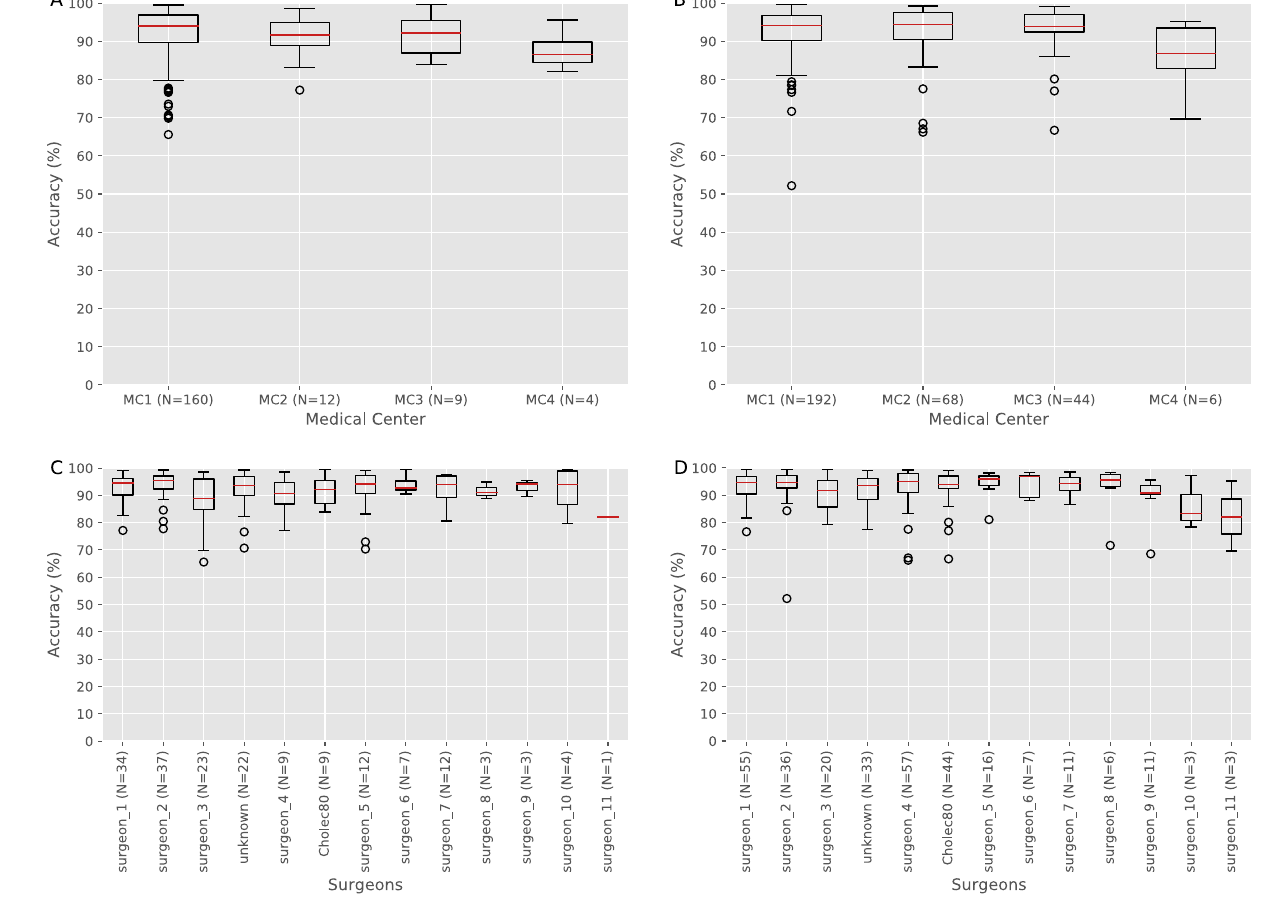
Figure 4. Medical centers and surgeons generalization evaluation. Accuracy boxplot for validation and test sets for different medical centers and surgeons. (N =) state the number of validation or test videos for each subset. Table S2. Only MC1-MC4 are shown since MC5-6 have only one sample each. ( C ) Validation set accuracy for surgeons. ( D ) Test set accuracy for surgeons. Absolute number of procedures for each surgeon is presented in Supplementary Table S3. Only surgeons with more than 10 videos are analyzed. The red line marks the median value, the box extends from the lower to the upper quartile values, the whiskers extend from the box to show the range of the data (not including outlier) and the circle points are marking data outliers (outliers are based on